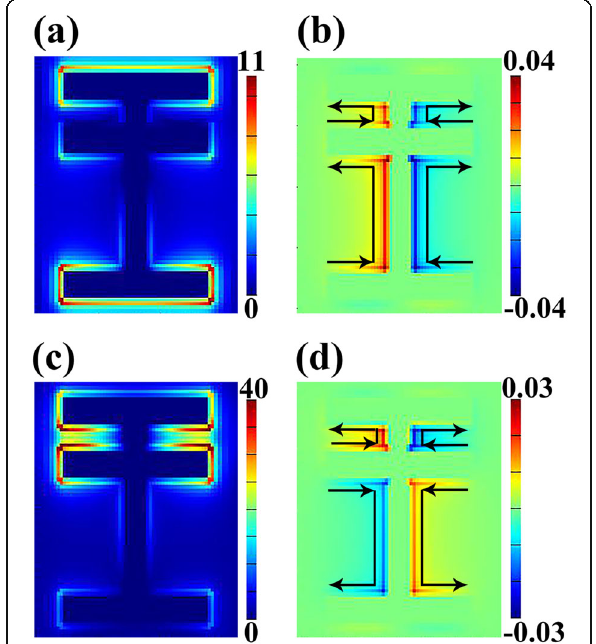
Fig. 3 Distributions of electric field ∣ E ∣ ( a ) and z component of magnetic field (H Z ) ( b ) at 0.430 THz ( R s ); distributions of ∣ E ∣ ( c ) and H Z ( d ) at 0.809 THz ( R d ); black arrows in b and d represent the direction of surface